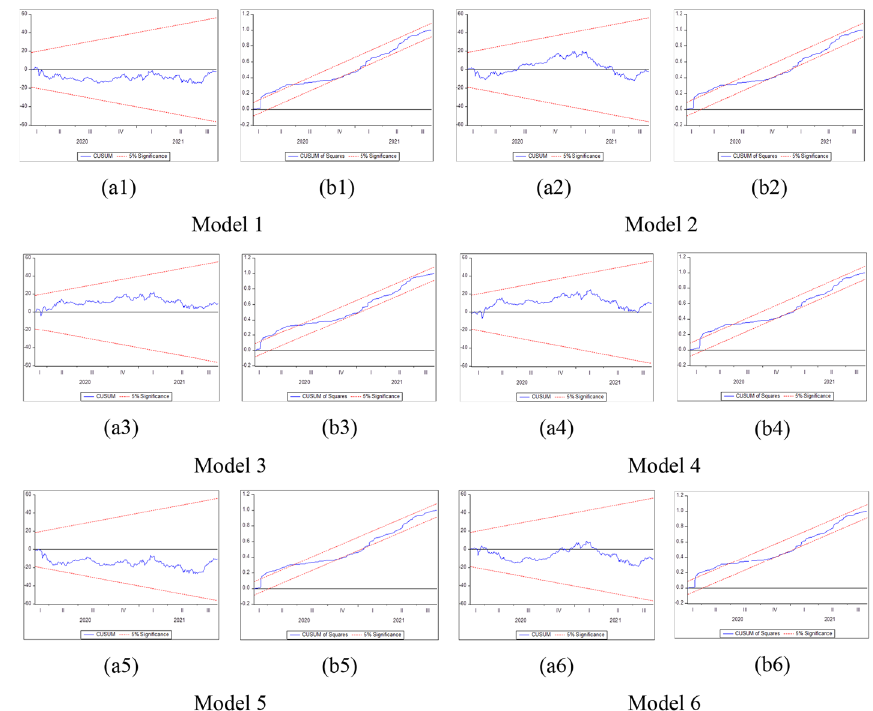
Fig. 3 NARDL plots of cumulative sum of recursive residuals—CUSUM (a1–a6) and cumulative sum square of recursive residuals—CUSUMSQ (b1–b6) for Models 1–6. Source Authors’ own work. Notes: The blue line is the solid line while the red lines that bounded the blue line are the critical bounds at 0.5. Variables’ description is provided in Table